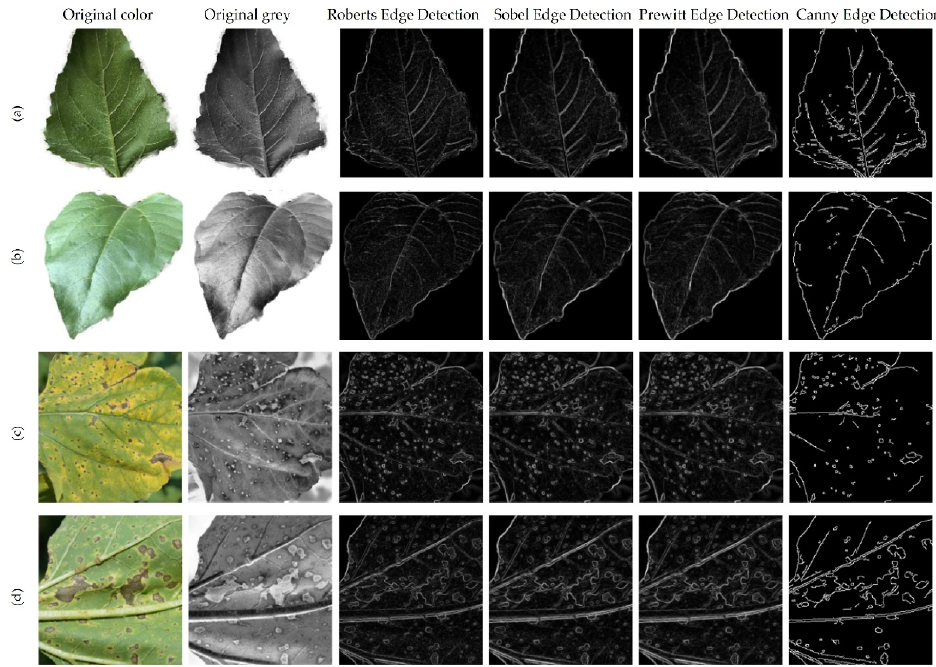
Figure 3. Edge detection methods applied to healthy and diseased leaves. ( a ) Lower side of healthy leaf; ( b ) Upper side of healthy leaf; ( c ) Upper side of diseased leaf; ( d ) Lower side of diseased leaf.